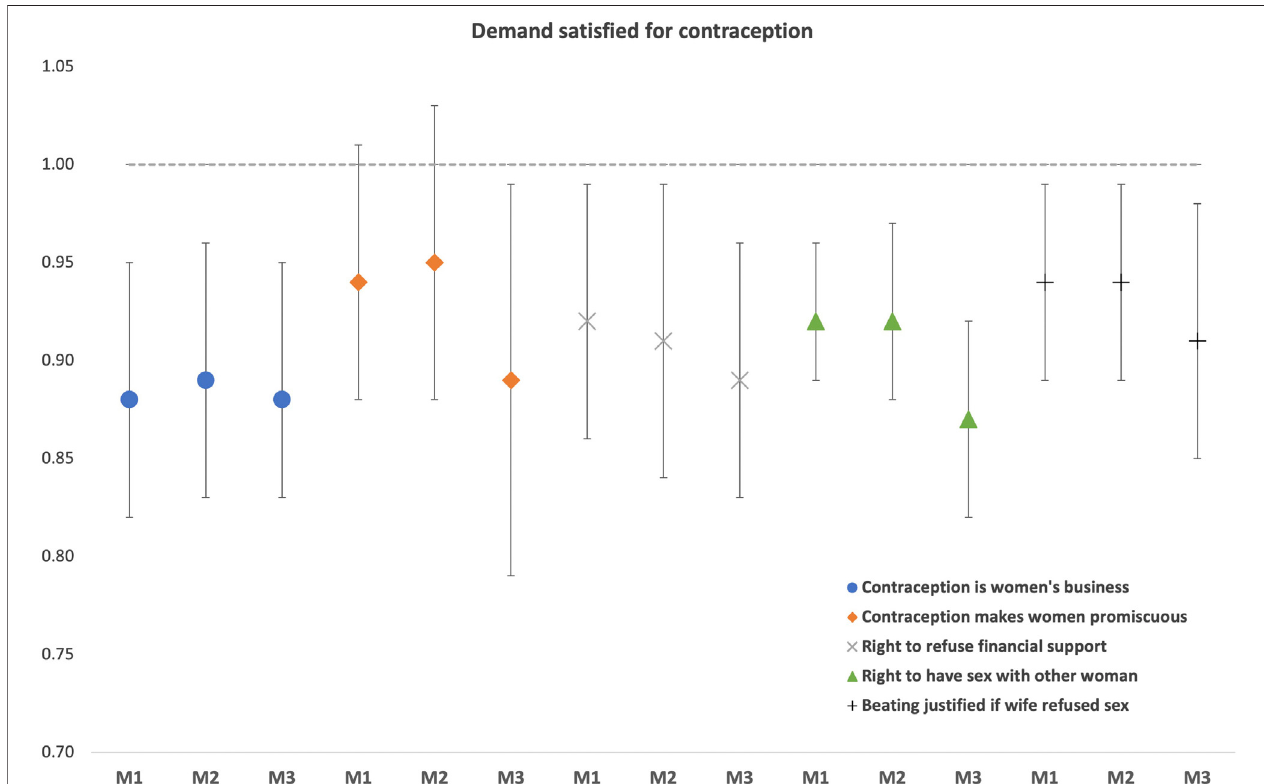
FIGURE 3 | Multilevel associations between men ’ s attitudinal norms and use of contraception: any method (Model 1: M1), modern method (Model 2: M2), and modern method excludingfemale sterilization (Model 3:M3), NFHS-4. Note: Resultsare from separate fully-adjusted models: baseline (M1), modern methods (M2), and modern methods but excluding female sterilization (M3), where we accounted for women ’ s empowerment indicators at the individual and district levels, as well as for demographic indicators at the individual level.